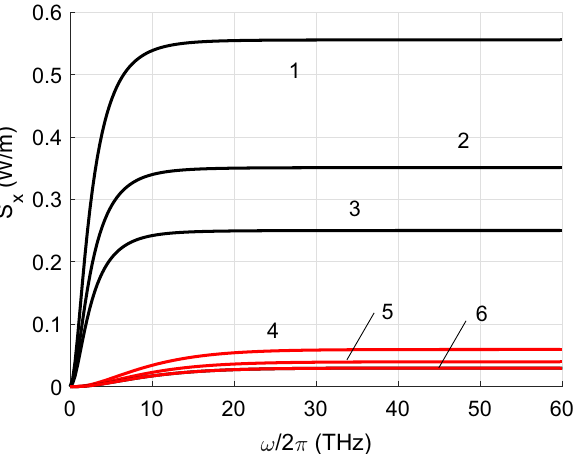
12 . Red curves relate to calculations =